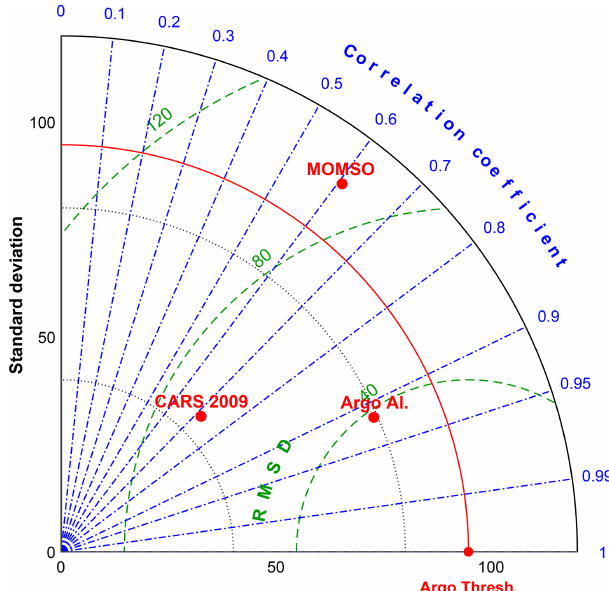
Figure 11. Taylor diagram of surface mixed layer depth in austral winter referred to as Argo Thresh. observational data compiled by Holte et al. (2017). The units for the standard deviation and root mean square deviations are meters. Argo Al. refers also to obser- vational data compiled by Holte et al. (2017) but based on a differ- ent algorithm. CARS 2009 is a climatology based on observations compiled by Condie and Dunn (2006), and MOMSO refers to the high-resolution reference simulation presented in this